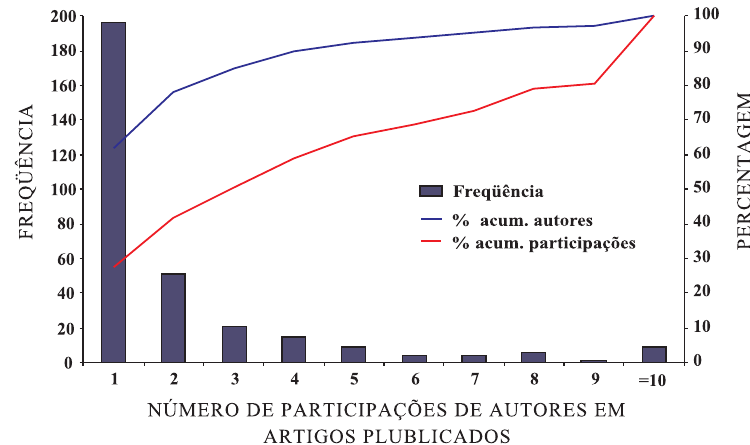
Figura 3. Histograma de participação de autores em artigos publicados sobre erosão do